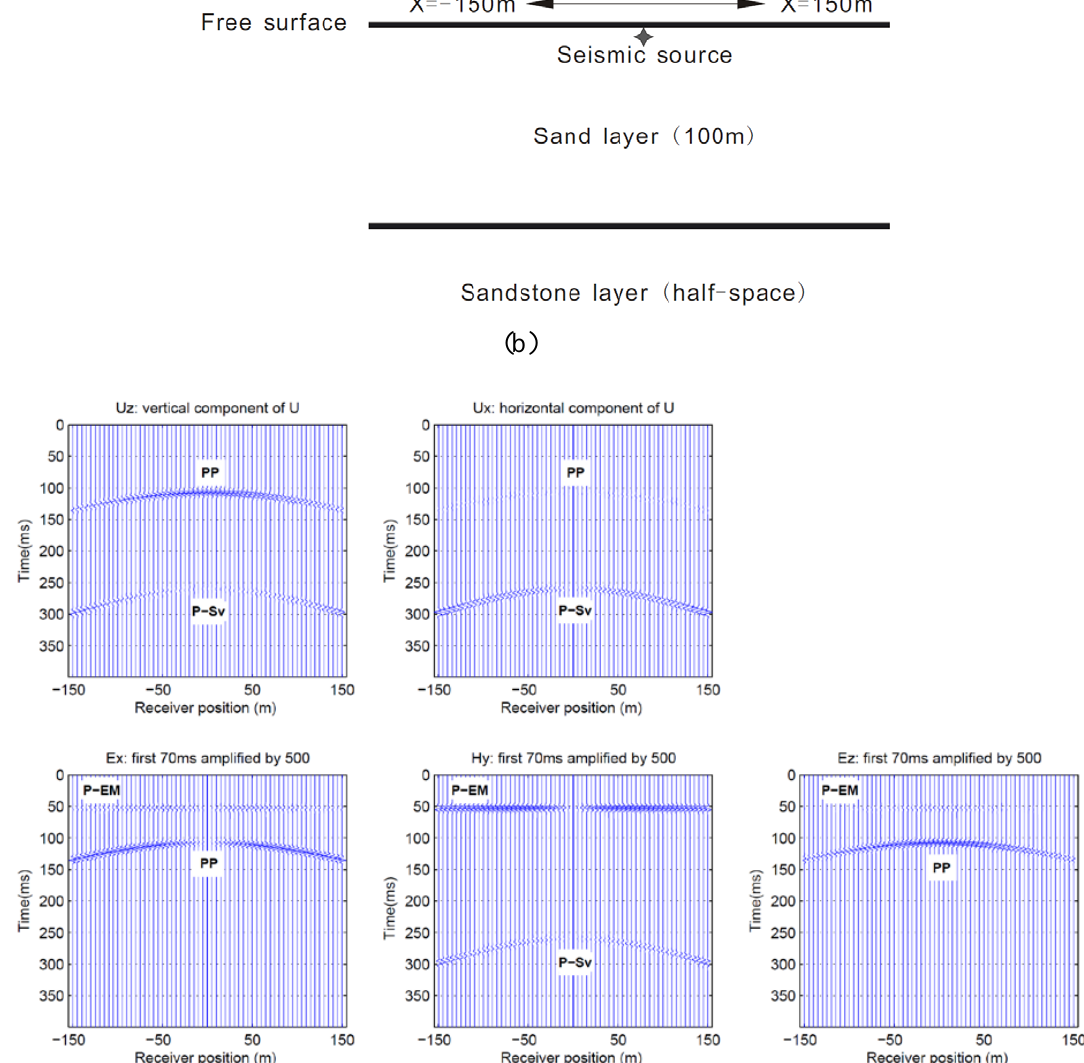
Figure 2 (a) A two-layer model with an explosion source near the free surface. (b) Seismograms and electro-seismograms of the two-layer model. Direct waves and free surface reflections are omitted in order to show coupled waves clearly. The P-to-EM conversions were amplified by a factor of 500.